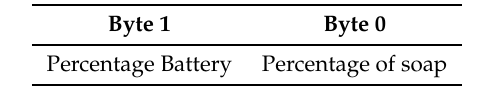
Table 5. Bytes sent by the soap dispenser in the frame payload in the application layer through the LoRa channel.